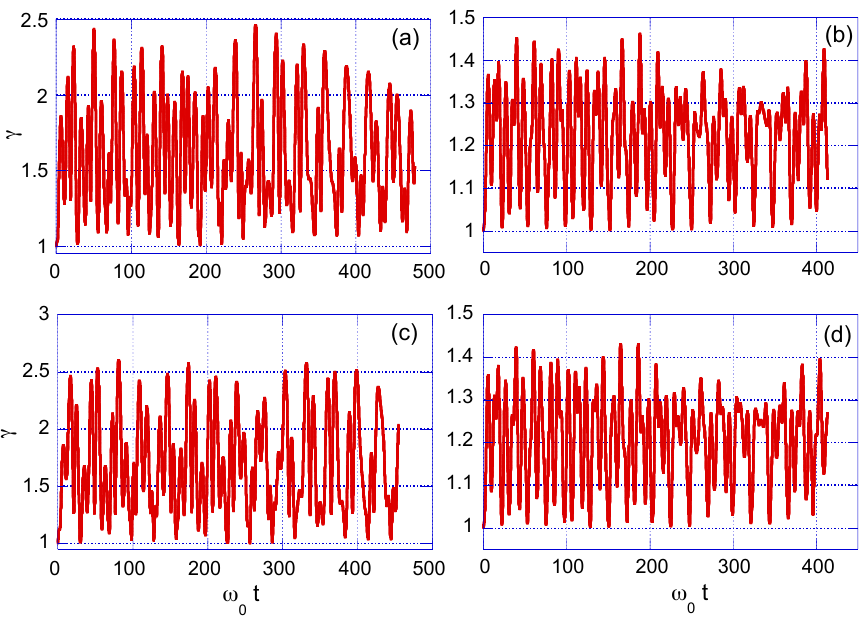
Figure 9. Time evolution of γ ( t ) for the cases displayed in Figure 6. As in previous plots, temporal axis is displayed in terms of the dimensionless variable ω 0 × t .